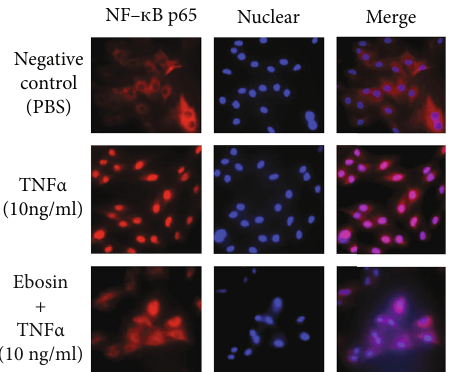
Figure 4: The e ff ect of ebosin on nuclear translocation of NF- κ B mediated by TNF- α in FLS. Indirect immuno fl uorescence with the speci fi c anti-NF- κ B p65 antibody was performed. Using a fl uorescence microscope, the cells were counterstained by Hoechst 33528 for nuclear staining.